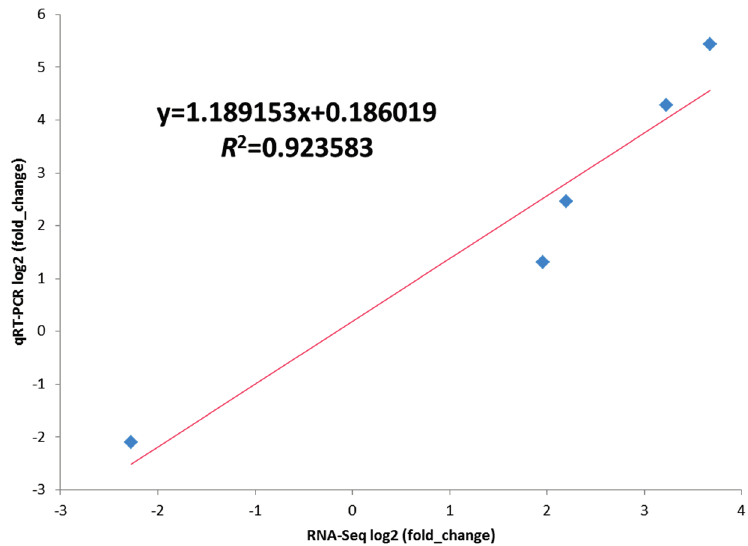
Figure 5. Line fit plot of Q-PCR results and RNA-Seq data for selected genes difference expression between MSTN propeptide transgenic and control mice. Linear regression model and R -Squared shown in the